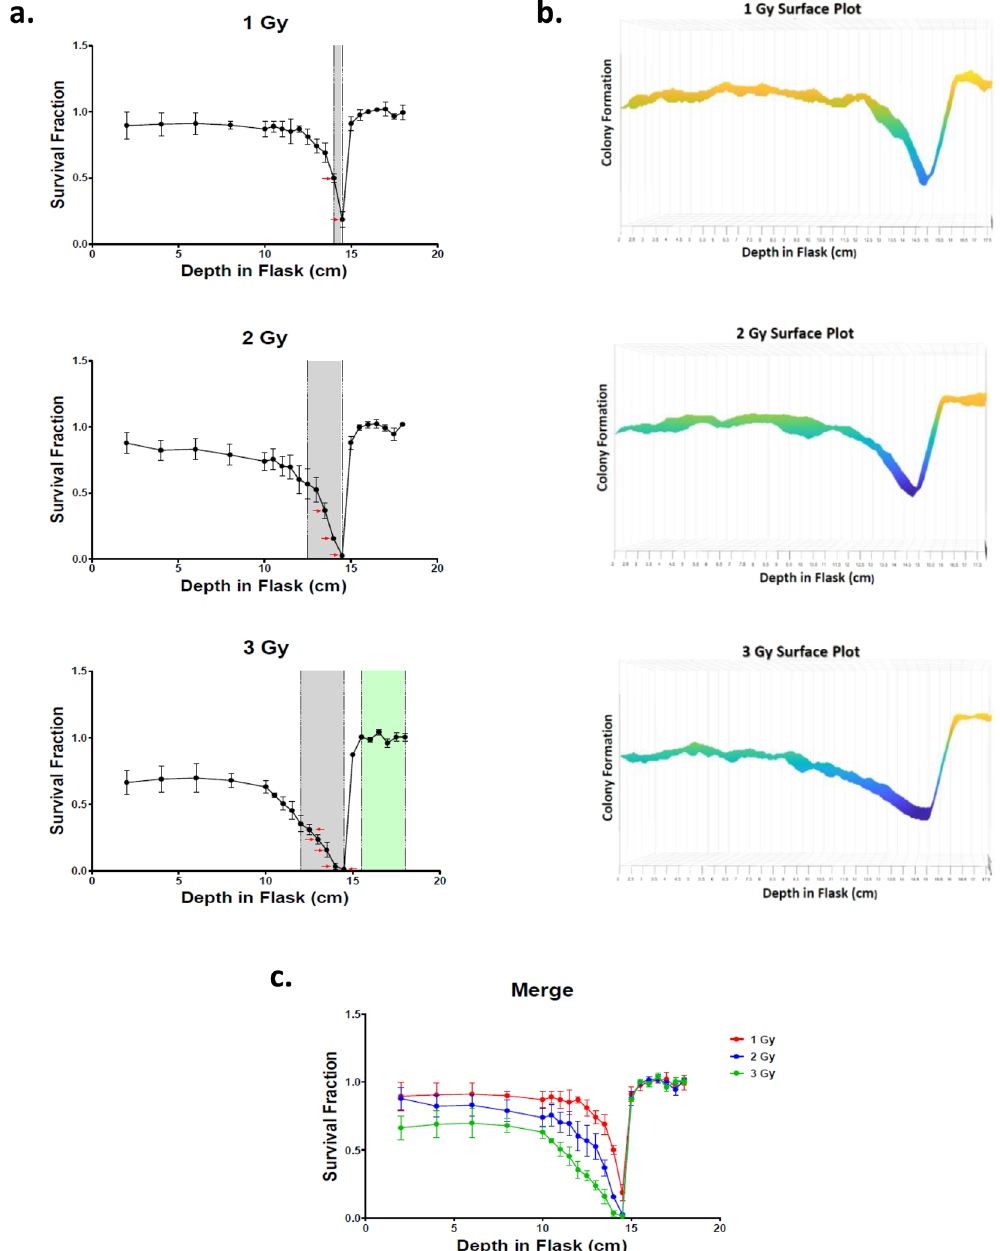
Figure 2. Cell survival vs depth following irradiation. ( a ) Survival fraction vs depth following treatment of 1, 2 or 3 Gy initial dosage. Areas highlighted in gray represent significant decrease ( P < 0 . 05 ), red arrows represent significant decrease ( P < 0 . 0001 ), areas highlighted in green represent significant increase ( P < 0 . 05 ), Dunnett’s Multiple Comparison Test. ( b ) Surface plot representation of colony formation at increasing depths for each experimental initial carbon-ion dosage. Surface plots were generated via MATLAB TM software. The surface plot displays the relative density of cell colonies as a function of flask depth and flask width; higher densities yielded higher arbitrary values on the Z-axis and vice versa. The color scheme used was standardized among all plots. The order of the color scheme from maximum cell colony density to minimum cell colony density (few or no cells present) is as follows: yellow, orange, green, blue, and purple, respectively. ( c ) Merge of all cell survival curves. Error bars indicate standard errors of the means from a minimum of three independent experiments per each one of our initial